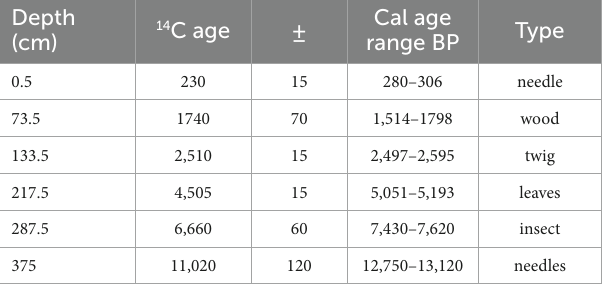
TABLE 1 Radiocarbon ages for Sargent Mountain Pond obtained from W. M. Keck Carbon Cycle AMS facility at UC Irvine, 2 sigma calendar year age ranges obtained from CALIB 8.2 (and rounded to the nearest 10 years), and the type of material analyzed. Depth 14 C (cm)